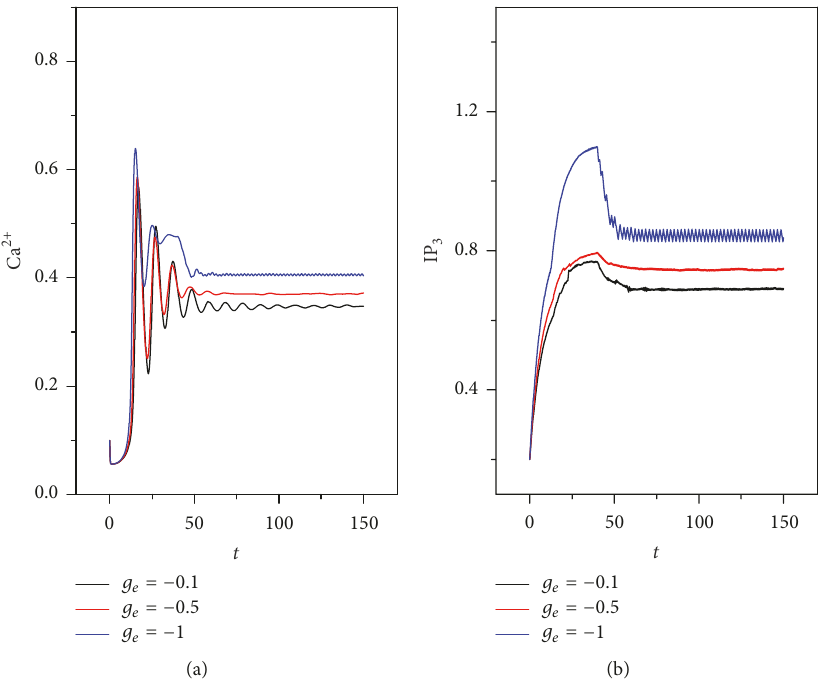
Figure 10: Fluctuation in Ca 2+ concentration and IP 3 concentration is calculated by applying different feedback gains 𝑔 𝑒 in autapse with time = 0.8 . And the external forcing current regulates the neuron by setting 𝐼 delay 𝜏 = 2 . The parameter is set as 𝑟 IP 3 𝑡 < 40